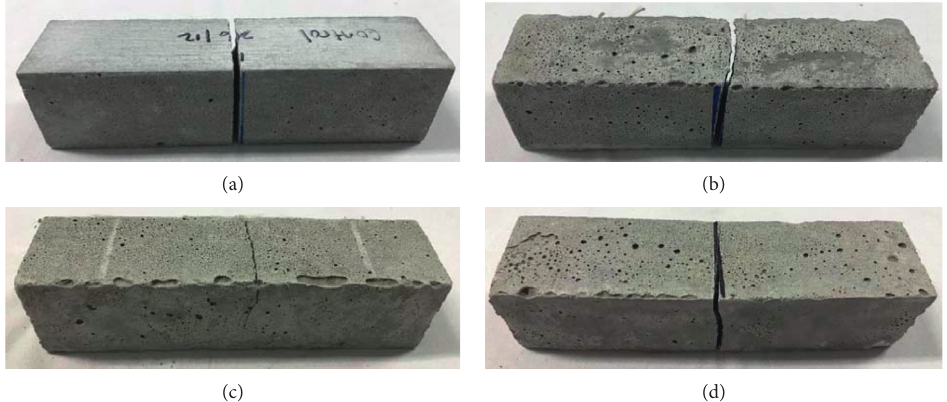
Figure 7: Fractured LCC after 3-point bending test: (a) control mix; (b) LCC-basalt; (c) LCC-PVA; (d)